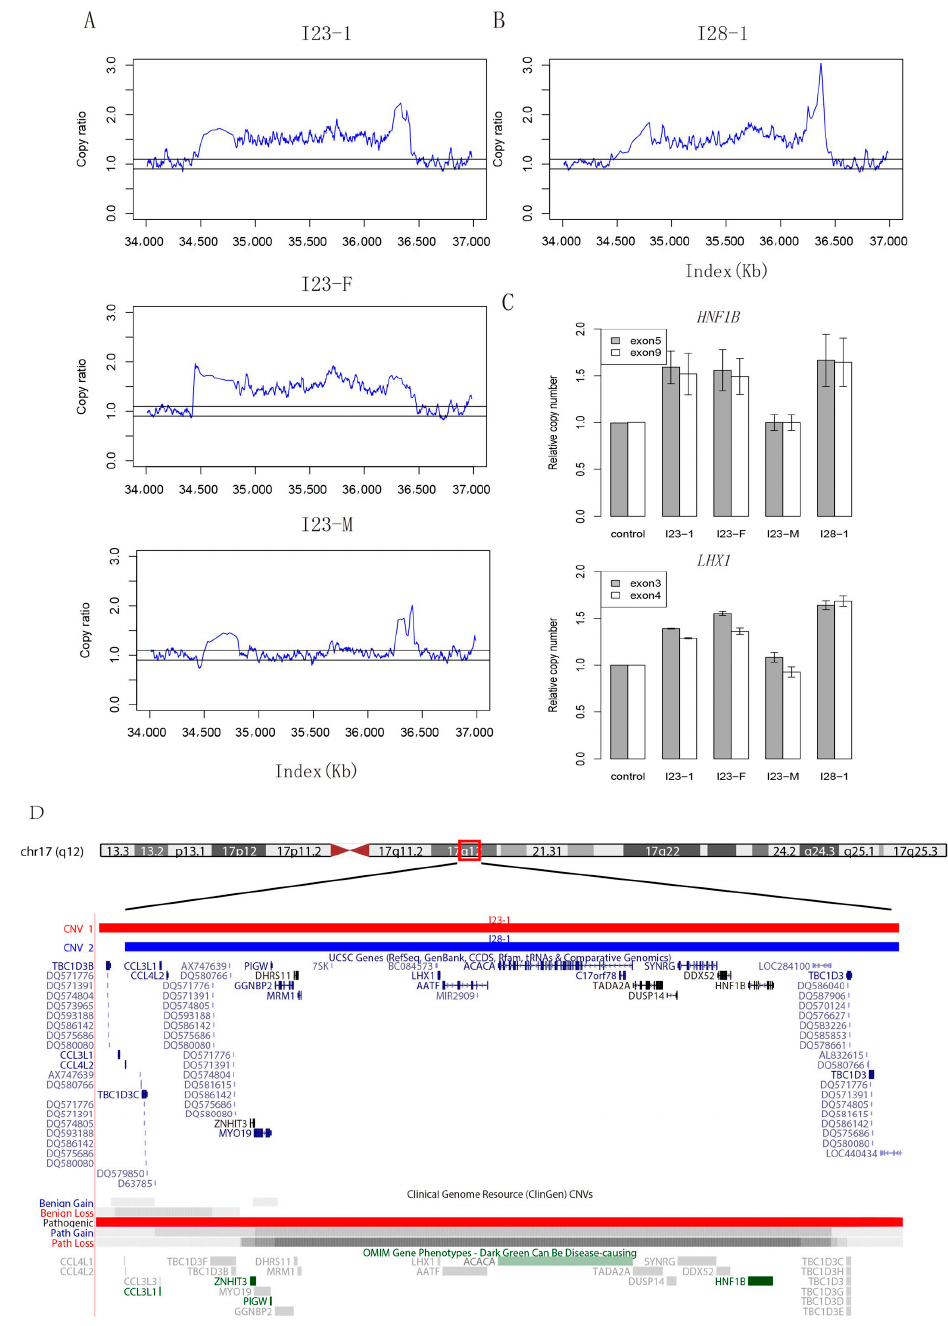
Figure 1. Copy number variants and validation of patients. ( A ) Copy ratio of mapped reads on 17q12 in family 23. Read depth shows a heterozygous fragment duplication in patient I23-1 and her father, while her mother has a normal structure in this region. I23-1: patient (described as I23 in text); I23-F: patient’s father; I23-M: patient’s mother. ( B ) Copy ratio of mapped reads on 17q12 in patient I28. Read depth shows a fragment duplication in patient I28-1 (patient I28 in the text). ( C ) Bar plot of q-PCR validation results for HNF1B and LHX1 . Primers were designed for two exons of these two genes. The height of a bar indicates the relative copy ratio compared with the control cell line (GM20764) having a normal diploid genome in these regions. ( D ) Integrative genomics view of copy number variants on 17q12 and affected genes. Genome browser of duplicated fragments detected in I23-1 and I28-1, along with affected genes within this region. Records of gain and loss of this fragment in public database are also shown at the